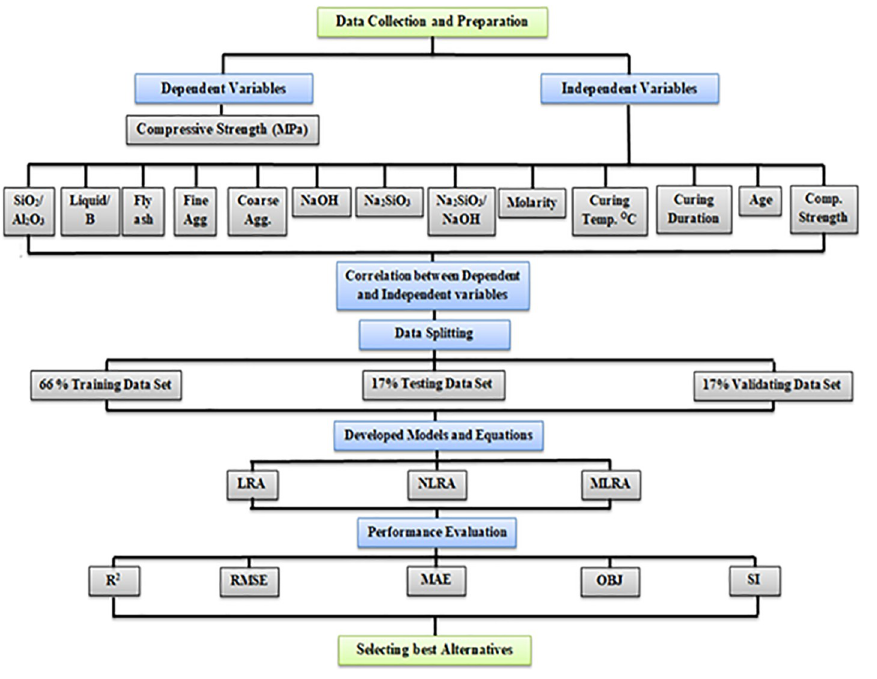
Fig 1. The flow chart diagram process followed in this study.